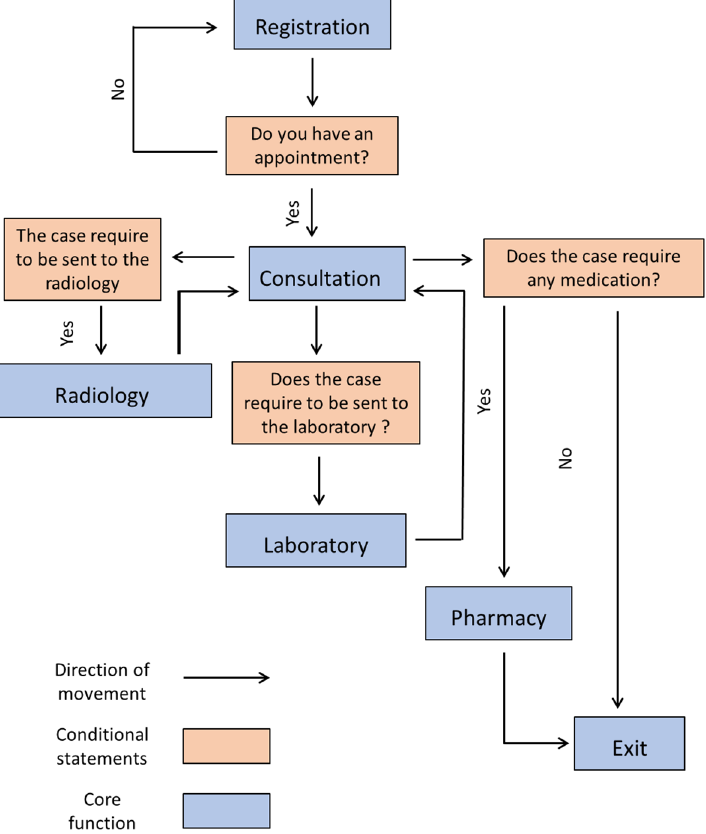
Figure 4. High-level workflow of an outpatient unit based on the MoH’s IMS guidelines [35].